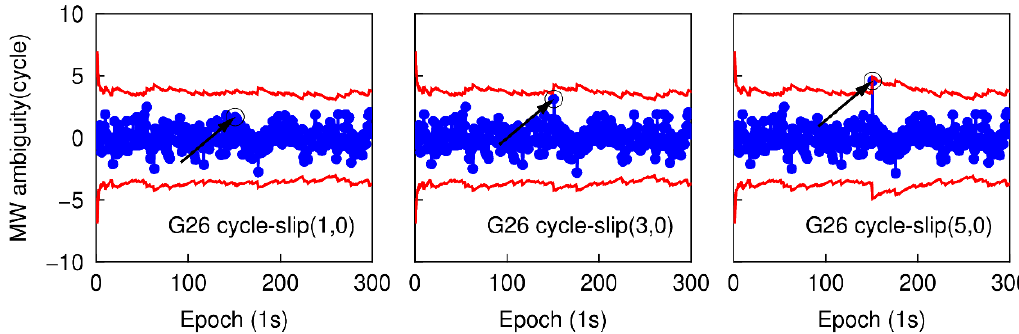
Figure 3. Small cycle-slip detection results using Melbourne–Wübbena (MW) combination for G26.